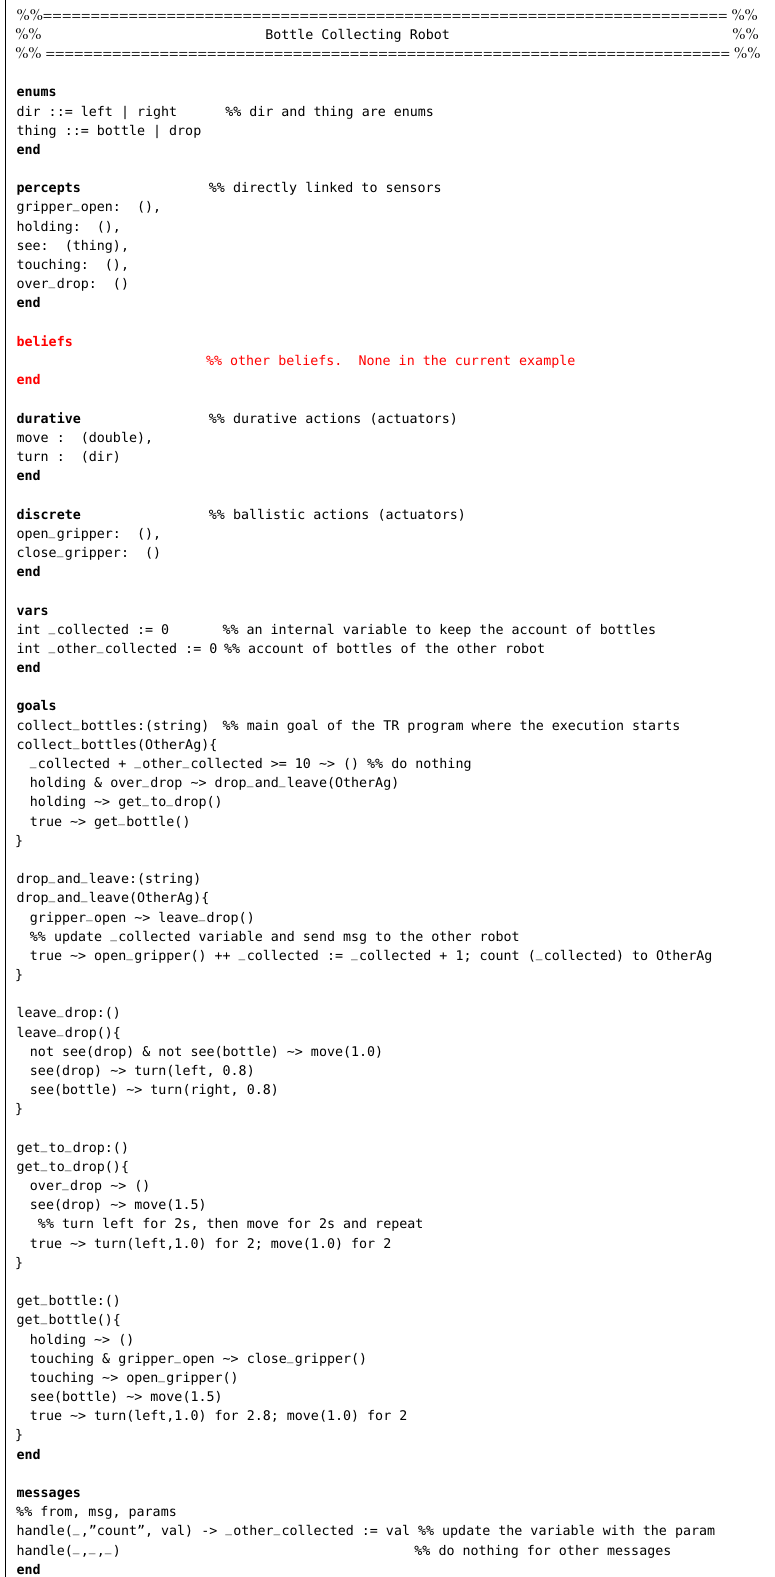
Table 2. TeleoR specification of a bottle collecting